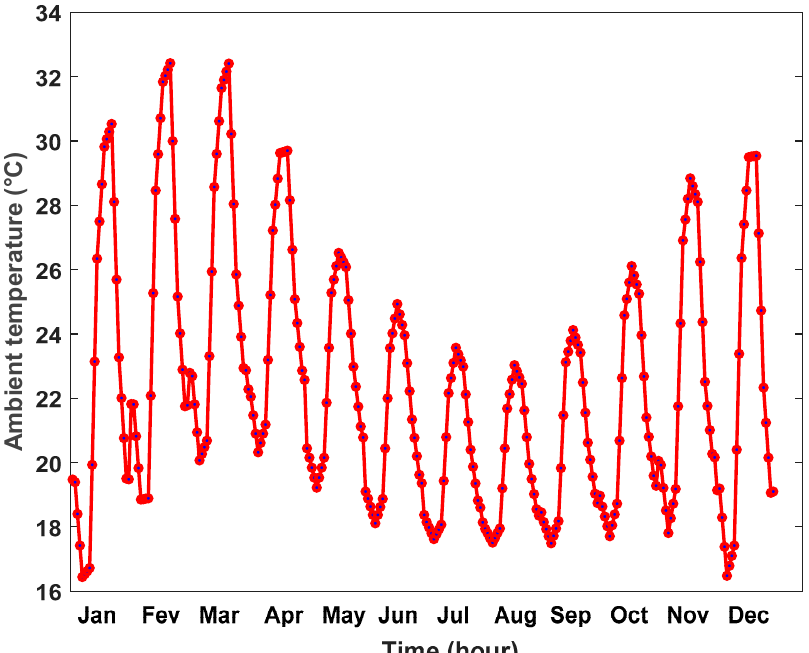
Figure 4. Monthly hourly ambient temperature over the year [33]. Table 2. Average monthly data of irradiation, ambient temperature, and wind speed (50 m height) of the study site [33,34].